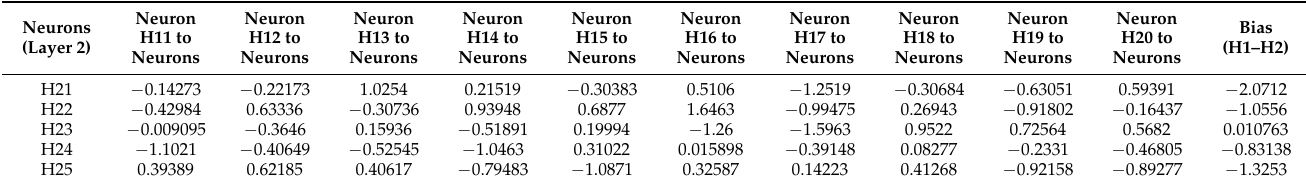
Table 8. Weight and bias between hidden layers.